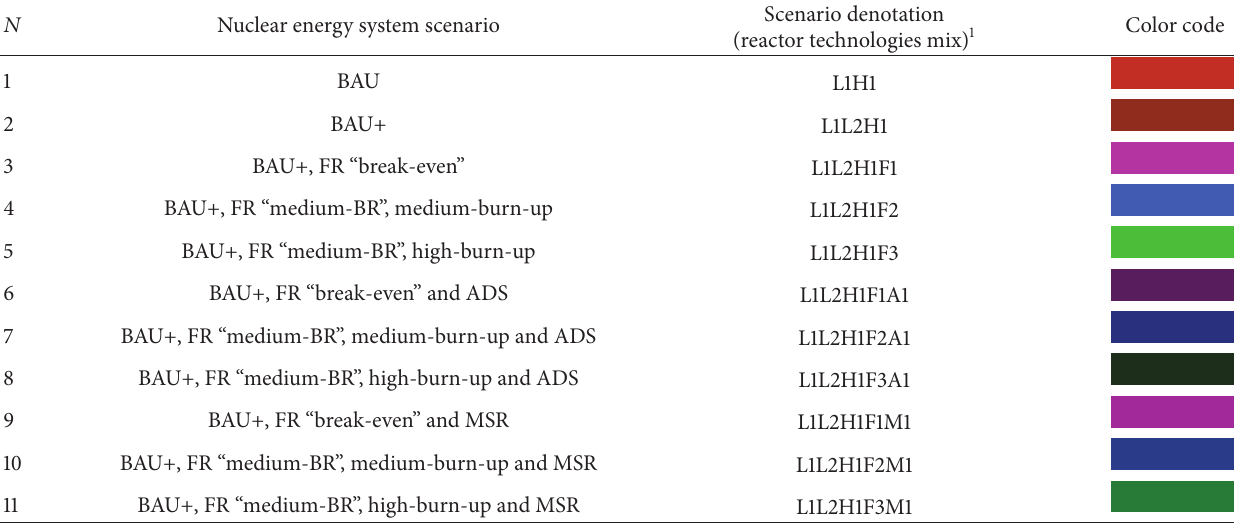
Table 1: Considered nuclear energy system evolution